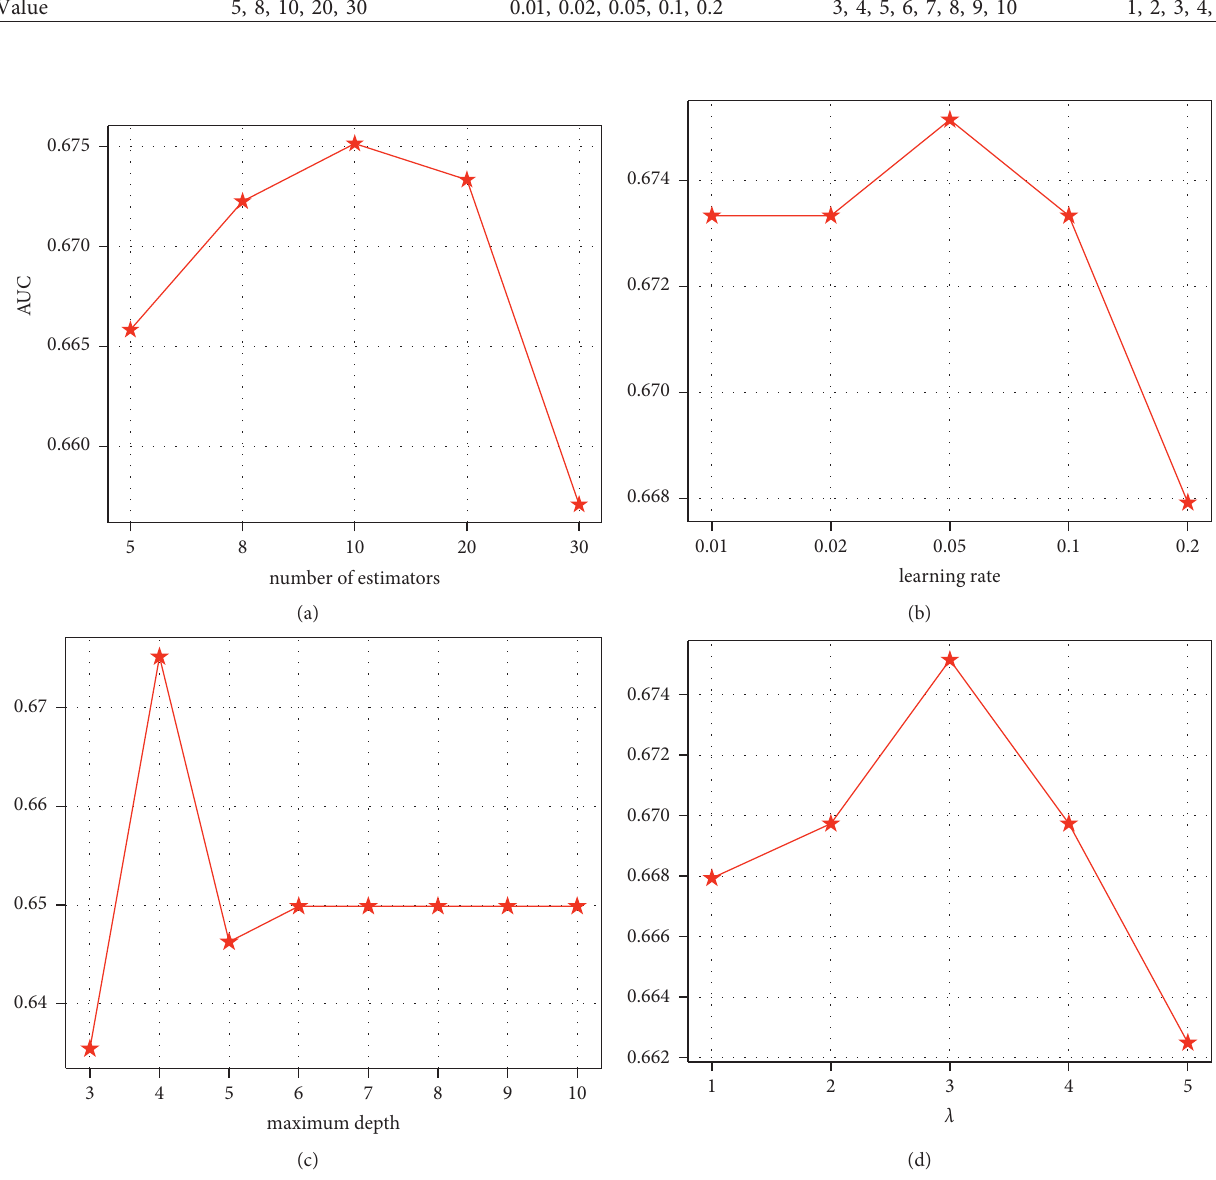
Figure 5: The AUC variation trends under different parameters. (a) Number of estimators. (b) Learning rate. (c) Maximum depth. (d) λ